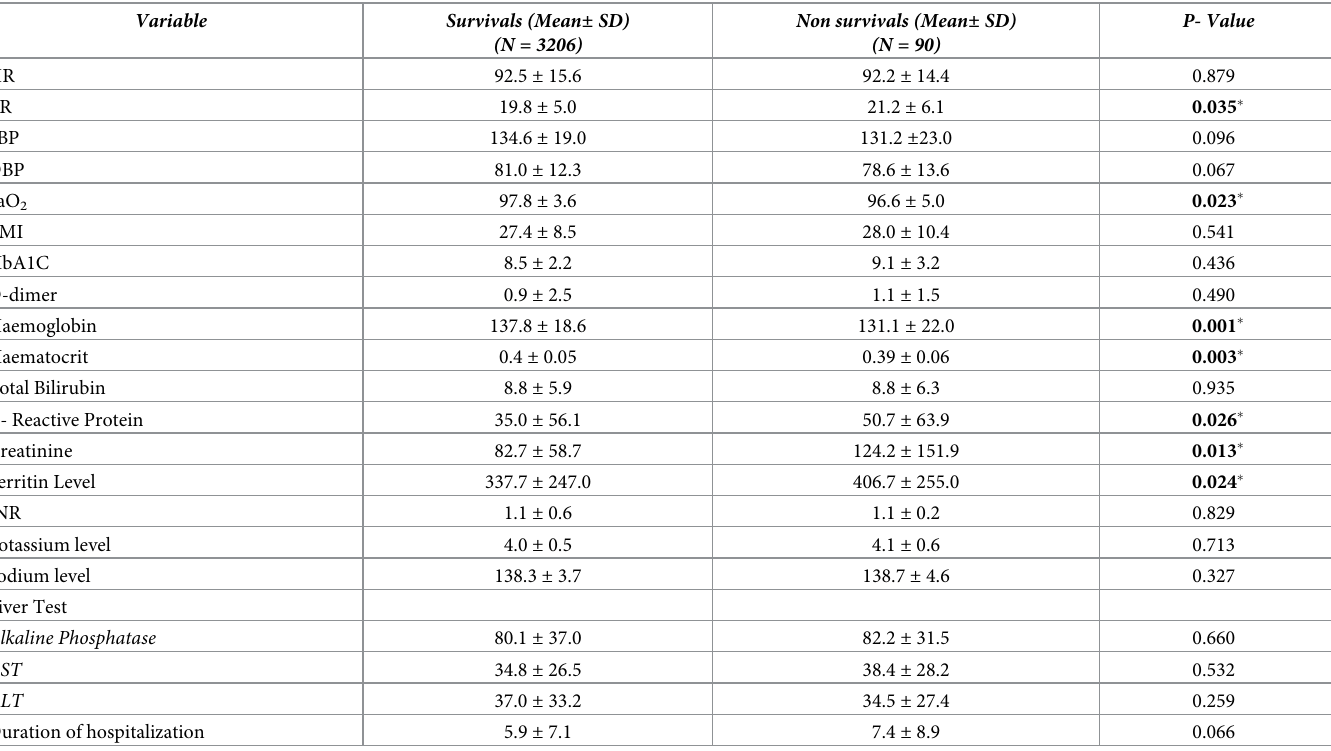
Table 3. Impact of vital signs, age and laboratory parameters on mortality following COVID-19